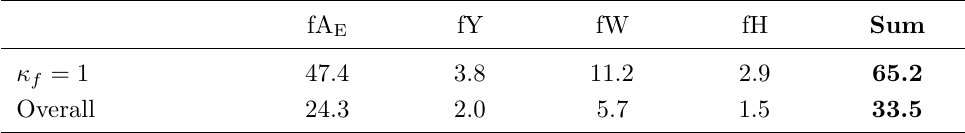
Table 5: Runtime-percentage of vulnerable